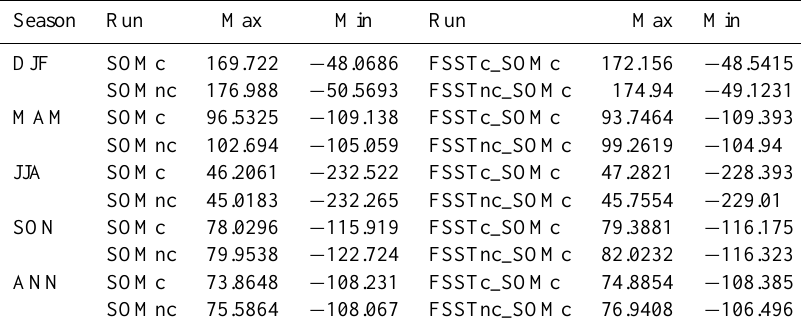
Table 6. The maximum and minimum of MMC for the control and no-carbon runs based on the SOM and fixed SST simulations. Unit is 10 9 kgs − 1